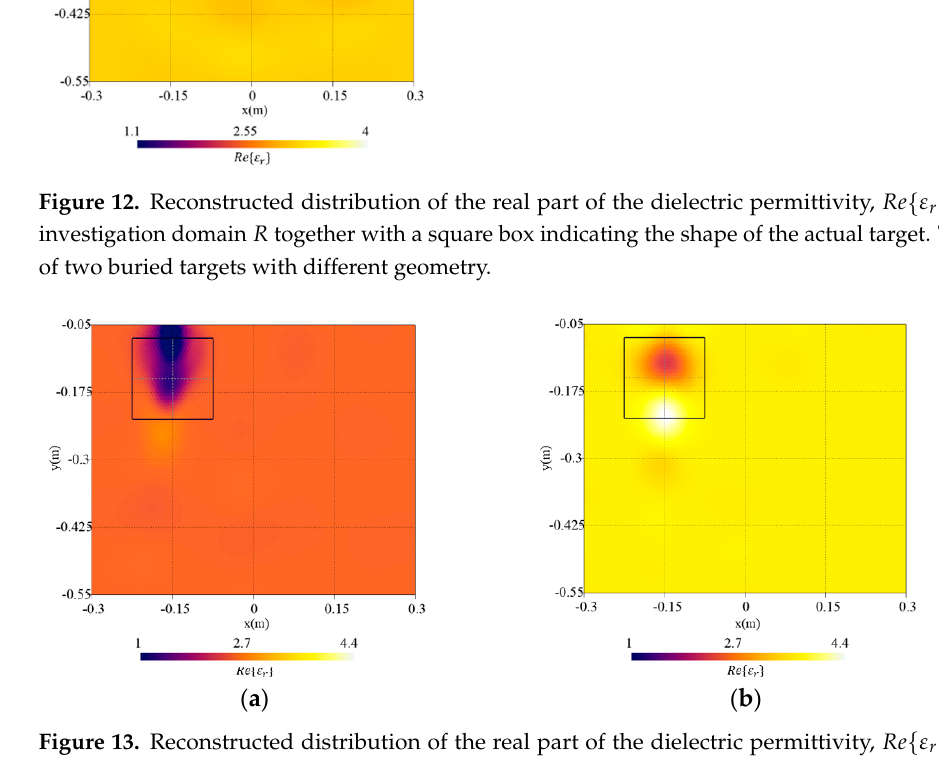
= ε − 0.5) and r , b r , b